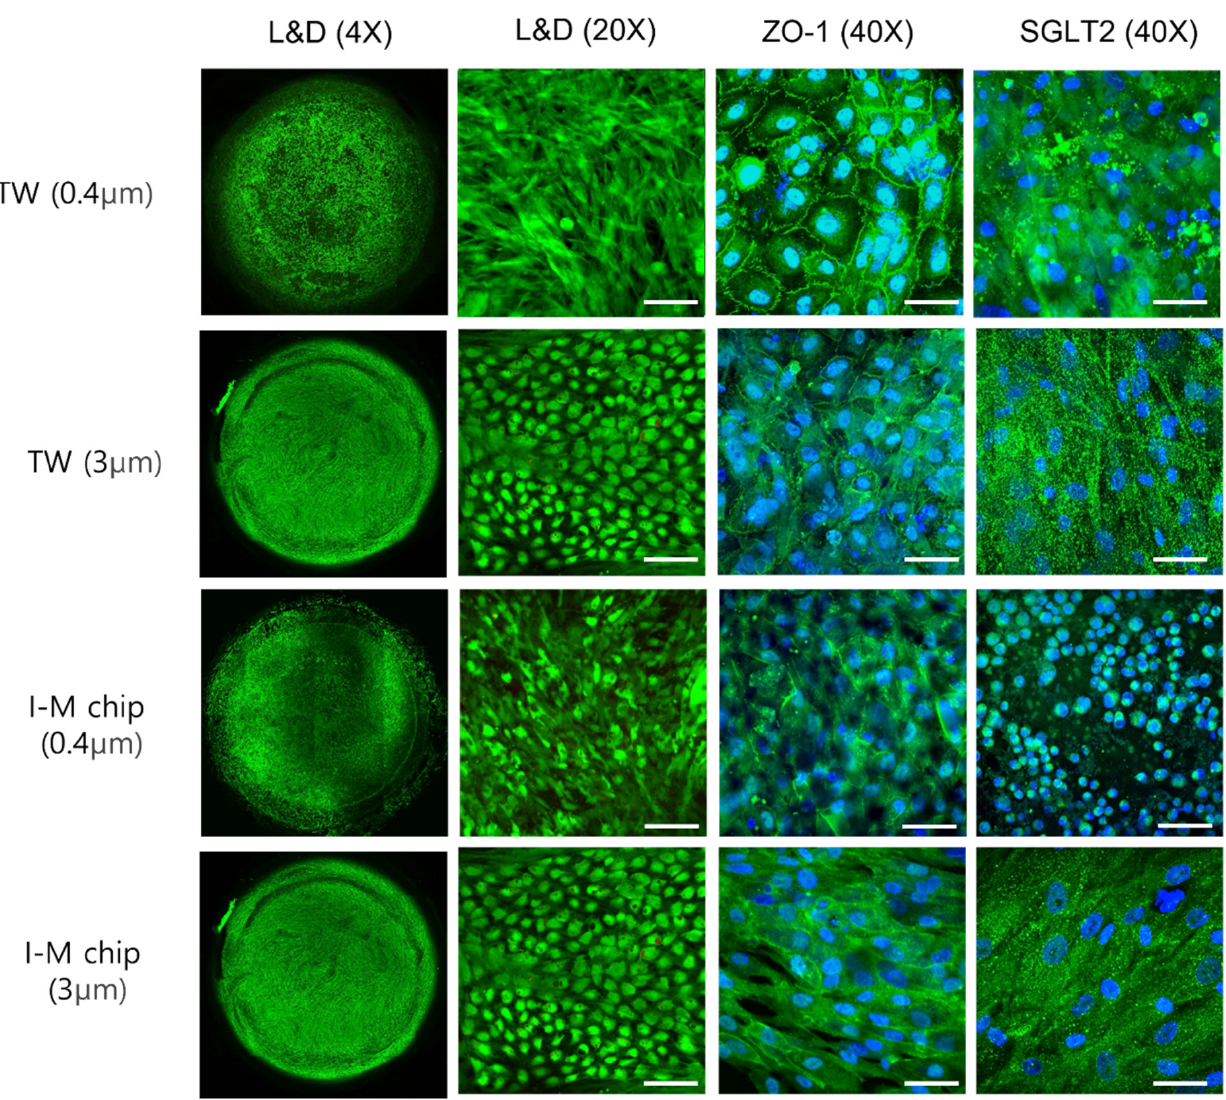
Figure 2. Using a confocal microscope, RPTEC’s L&D images (4× and 20×) and immunofluorescence images (40×) were observed in TW and I-M Chip using a confocal microscope, live–dead cell image observation throughout the membrane, L&D scale bar 100 μ m. IF (ZO-1 and SGLT2) scale bar is 50 μ m.